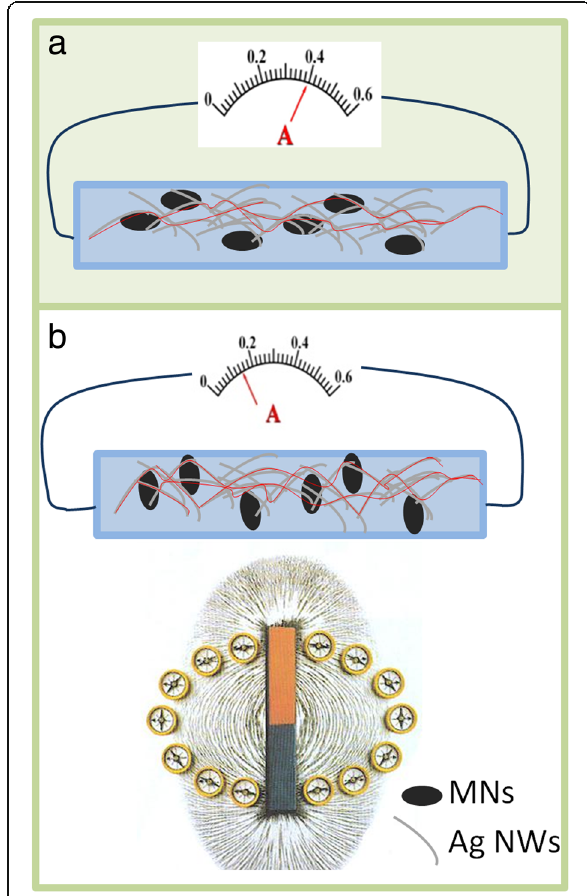
Fig. 9 Schematic sensing model of AgNWs & MNs-PDMS-based soft magnetic field